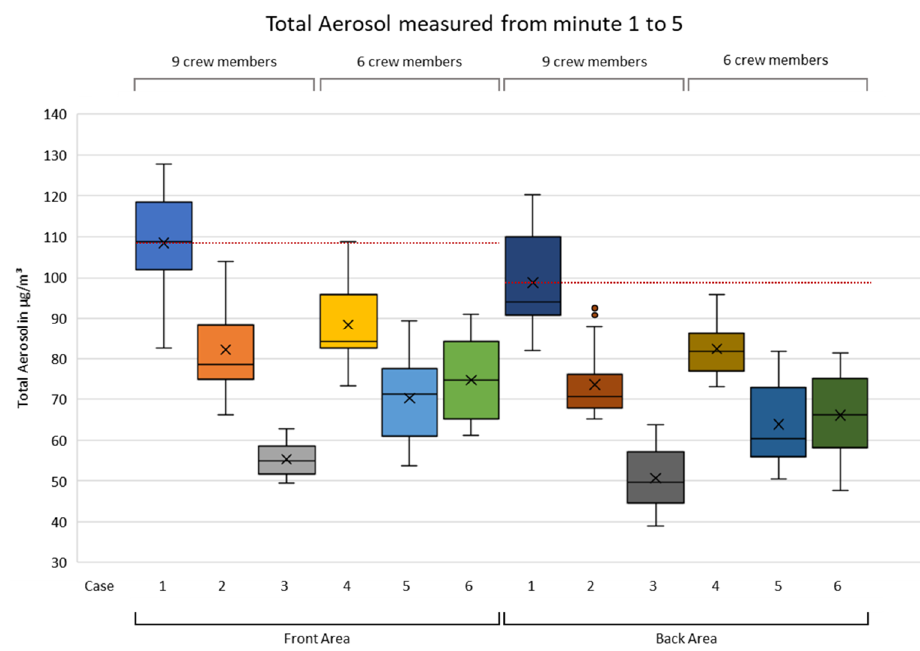
Figure 4. Total aerosol burden measured from minute 1 to 5.